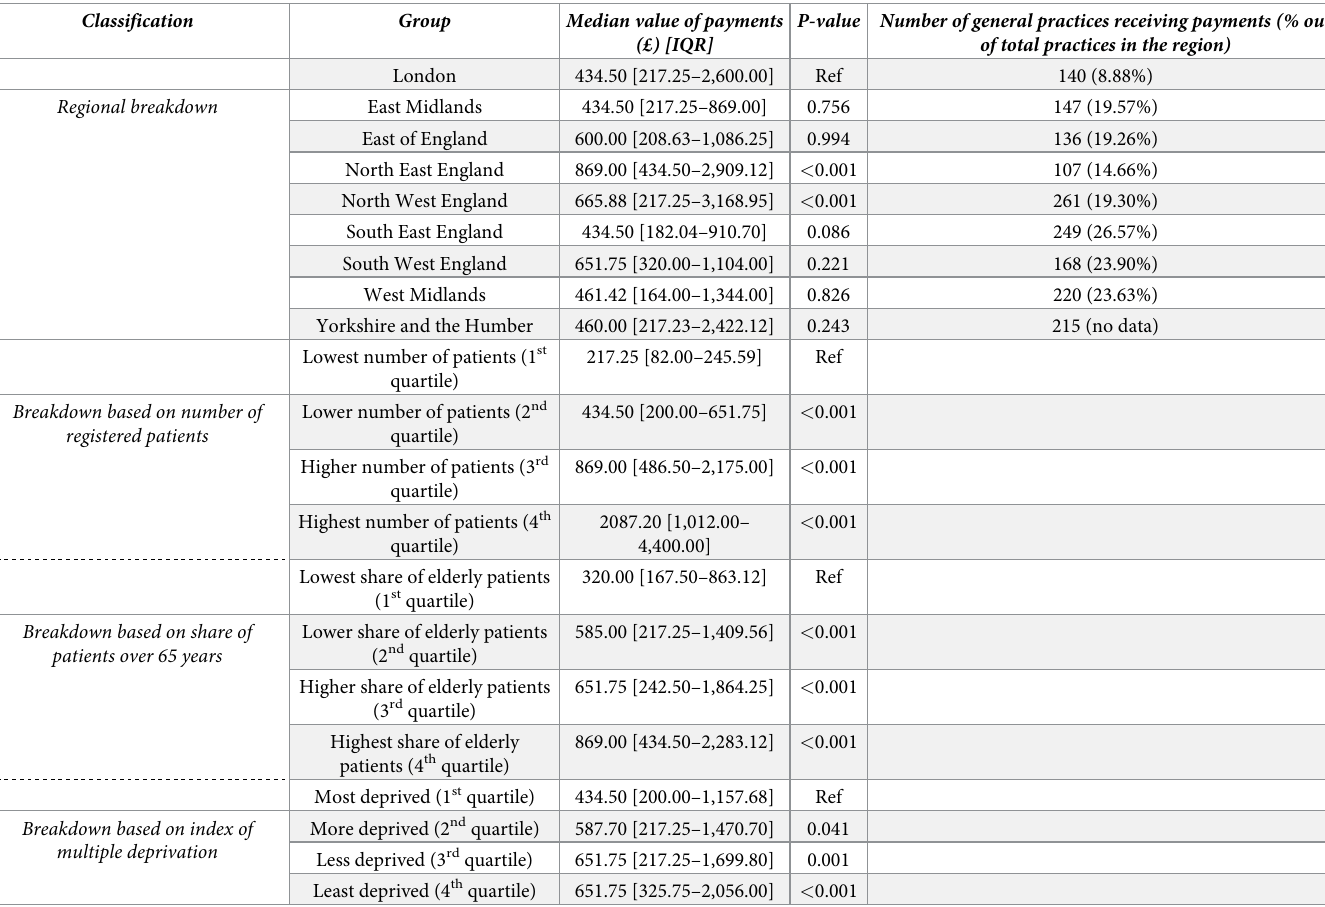
Table 3. Breakdown of drug company payments according to general practice